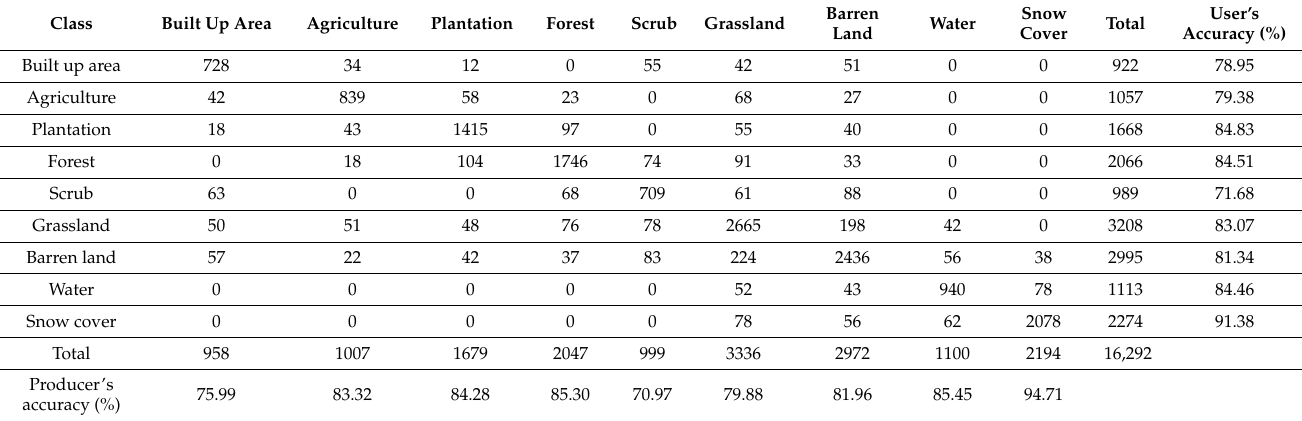
Table A1. The confusion matrix used for the accuracy